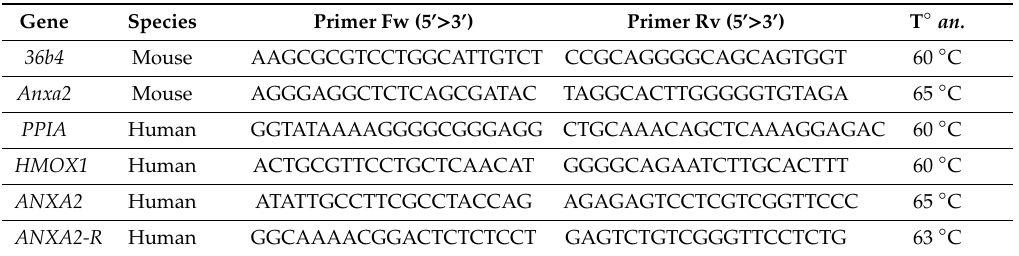
Table 1. Table of employed primers, containing the gene name, specie, sequences, and annealing temperature (Tº